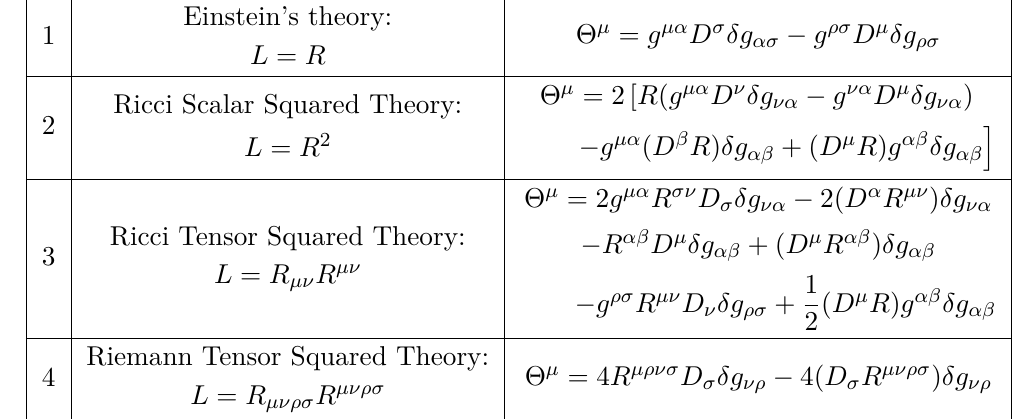
Table 4 . Symplectic Potential for Einstein gravity and other four derivative theories of gravity.